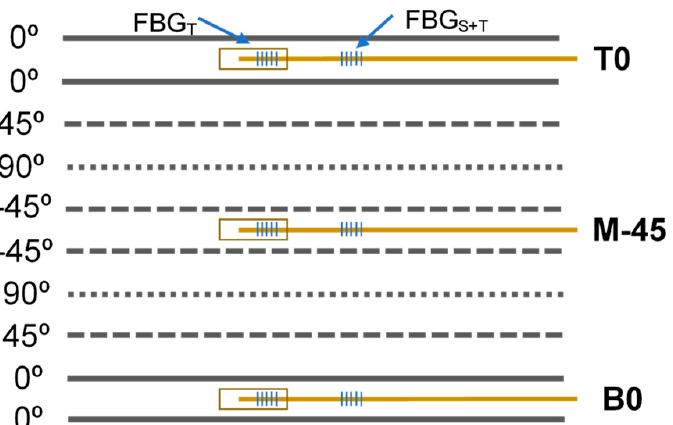
Figure 1. Schematic of optical fibre through − thickness embedding locations.